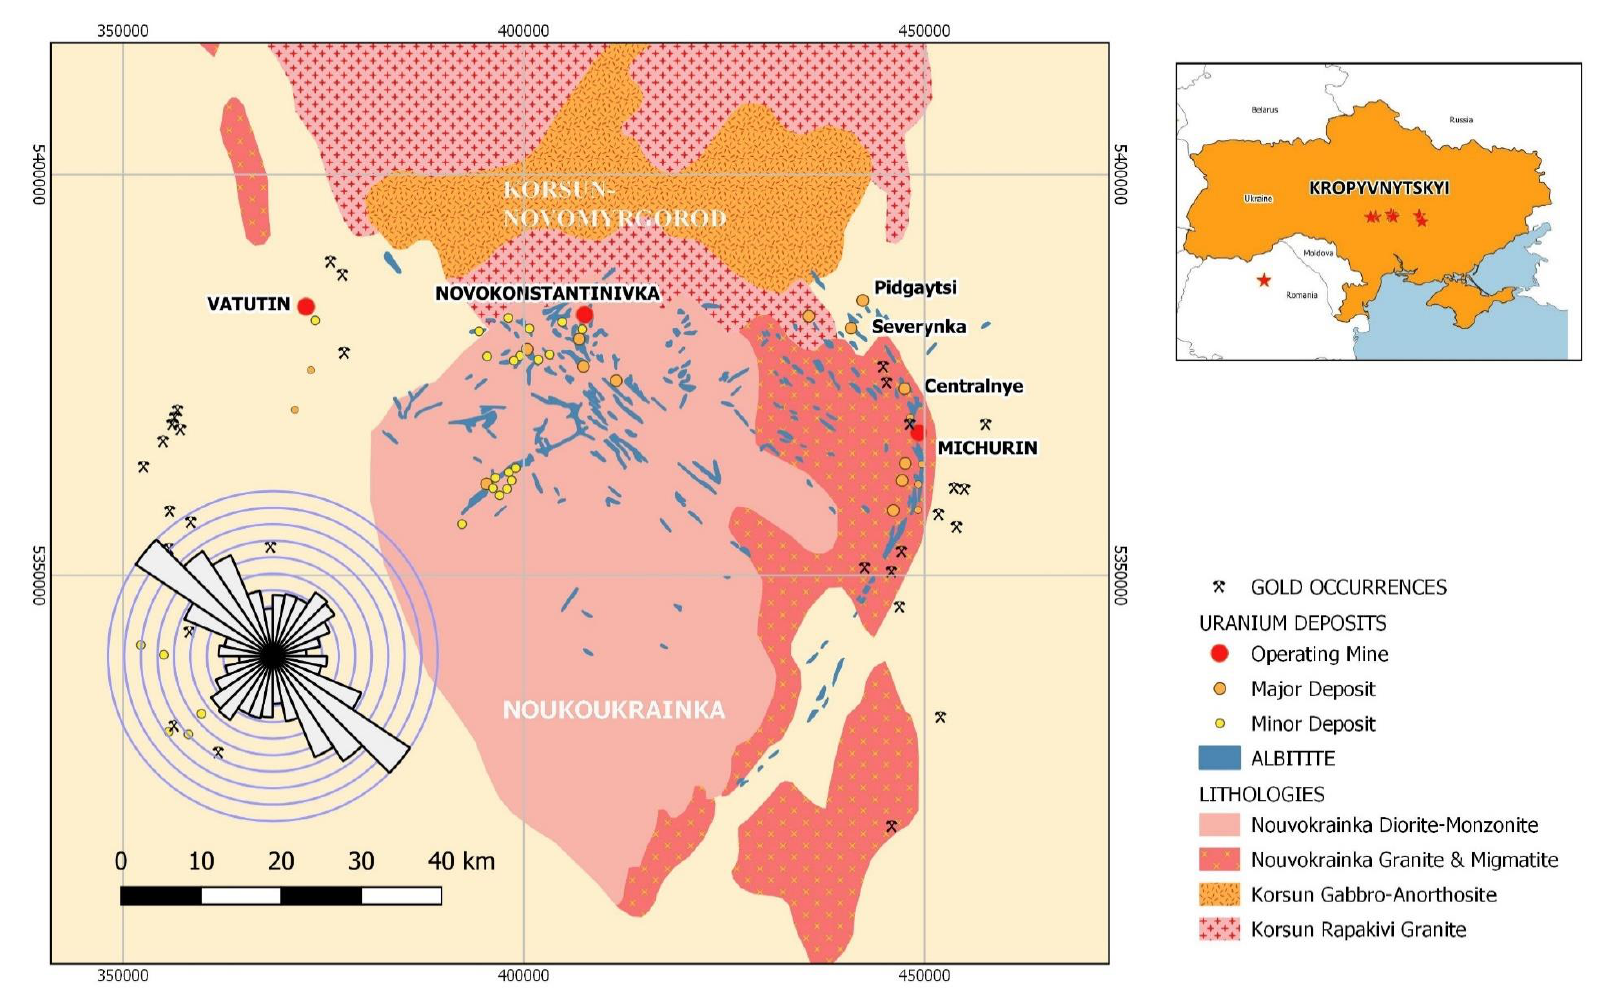
Figure 2. Geological map of the Kropyvnytskyi district, Ukraine, based on